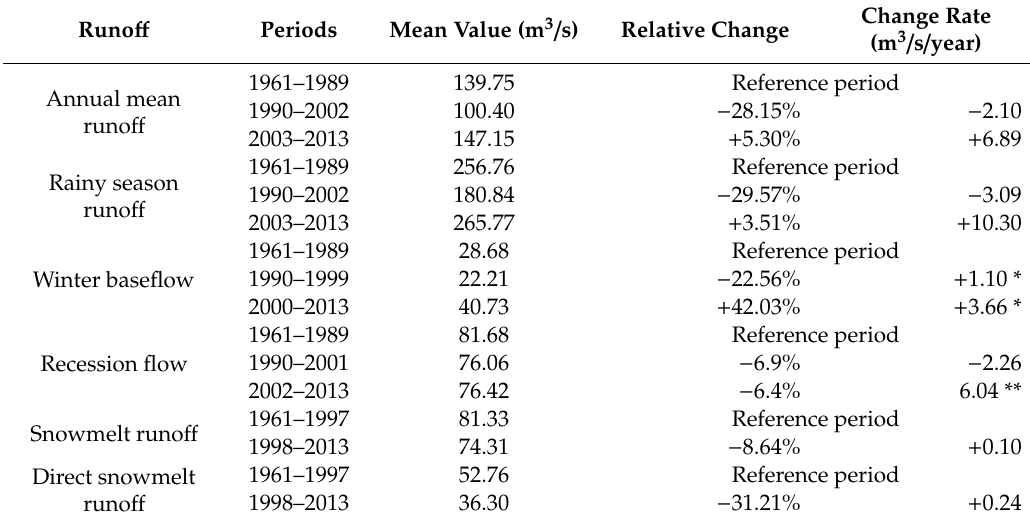
Table 3. Runo ff changes in respective periods.